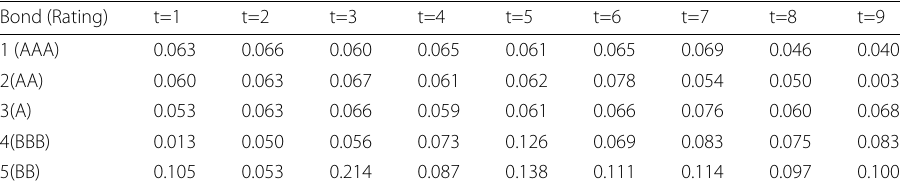
Table 3 Average simulated returns for Service